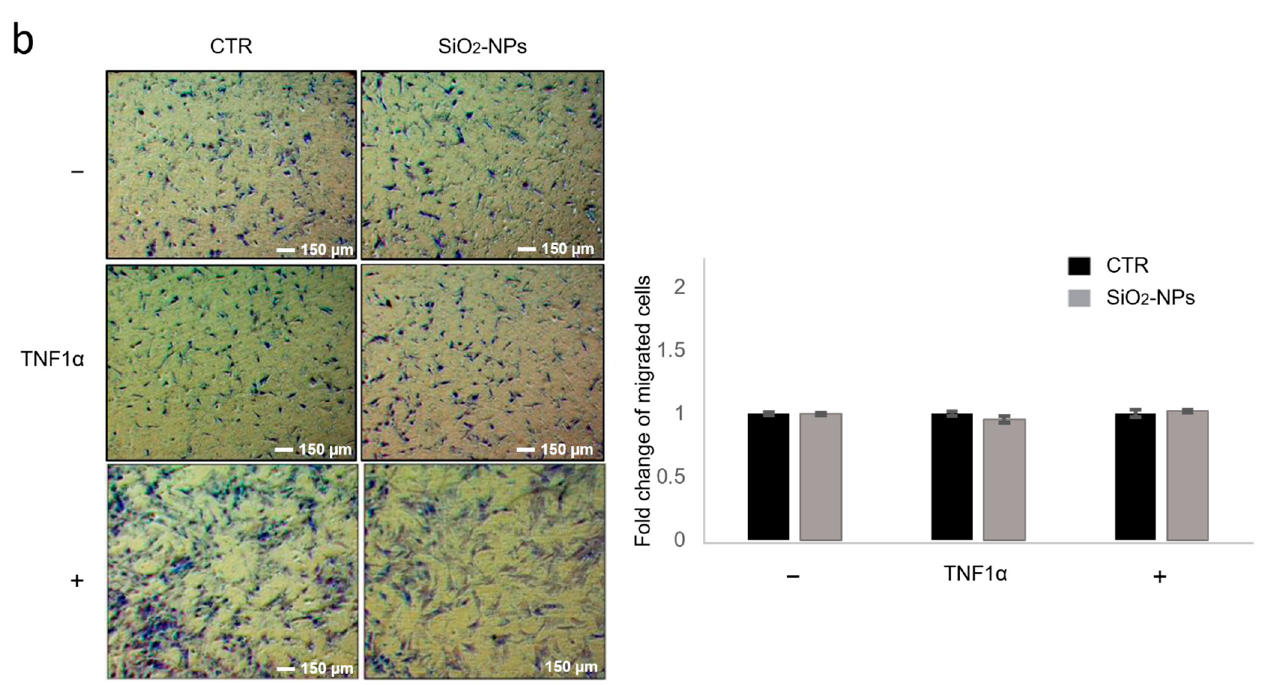
Figure 3. SiO 2 -NPs do not modify either TNFR surface expression or migration toward TNF1 α in hMSCs. ( a ) Fifty thousand of both untreated (CTR) and SiO 2 -NP-treated hMSCs were incubated with anti-TNFR antibody and fluorescence intensity was measured by flow cytometry after 16 h of SiO 2 -NP treatment. Data shown are cytometric profiles of a representative sample of each experimental group: background signal of cells without antibody incubation (grey), control cells (red), SiO 2 -NP-treated cells (blue). Box plot shows the mean fluorescence intensity expressed as mean ± SD. ( b ) Representative images of migration of both CTR and SiO 2 -NP-treated hMSCs in the presence of chemoattractant TNF α (10 ng/mL) or medium with either 0.5% FBS (negative control; − ) or 30% FBS (positive control; +). Once fixed, hMSCs were stained with crystal violet. Magnification 4×; scale bar 150 μ m. Bar graphs represent the quantification of migrated cells normalized to CTR experimental group and expressed as fold change of migrated cells. Bars show mean ± SEM. n = 3.